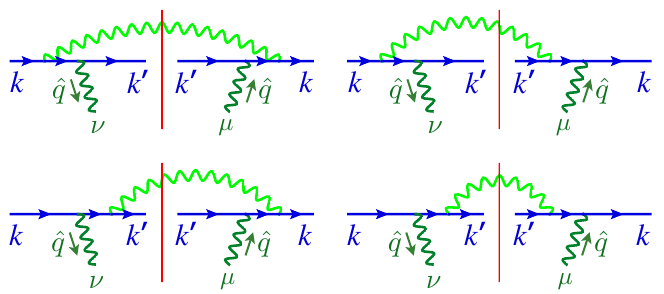
Figure 22 . Real photon emission diagrams for the calculation of the leptonic tensor at NLO.